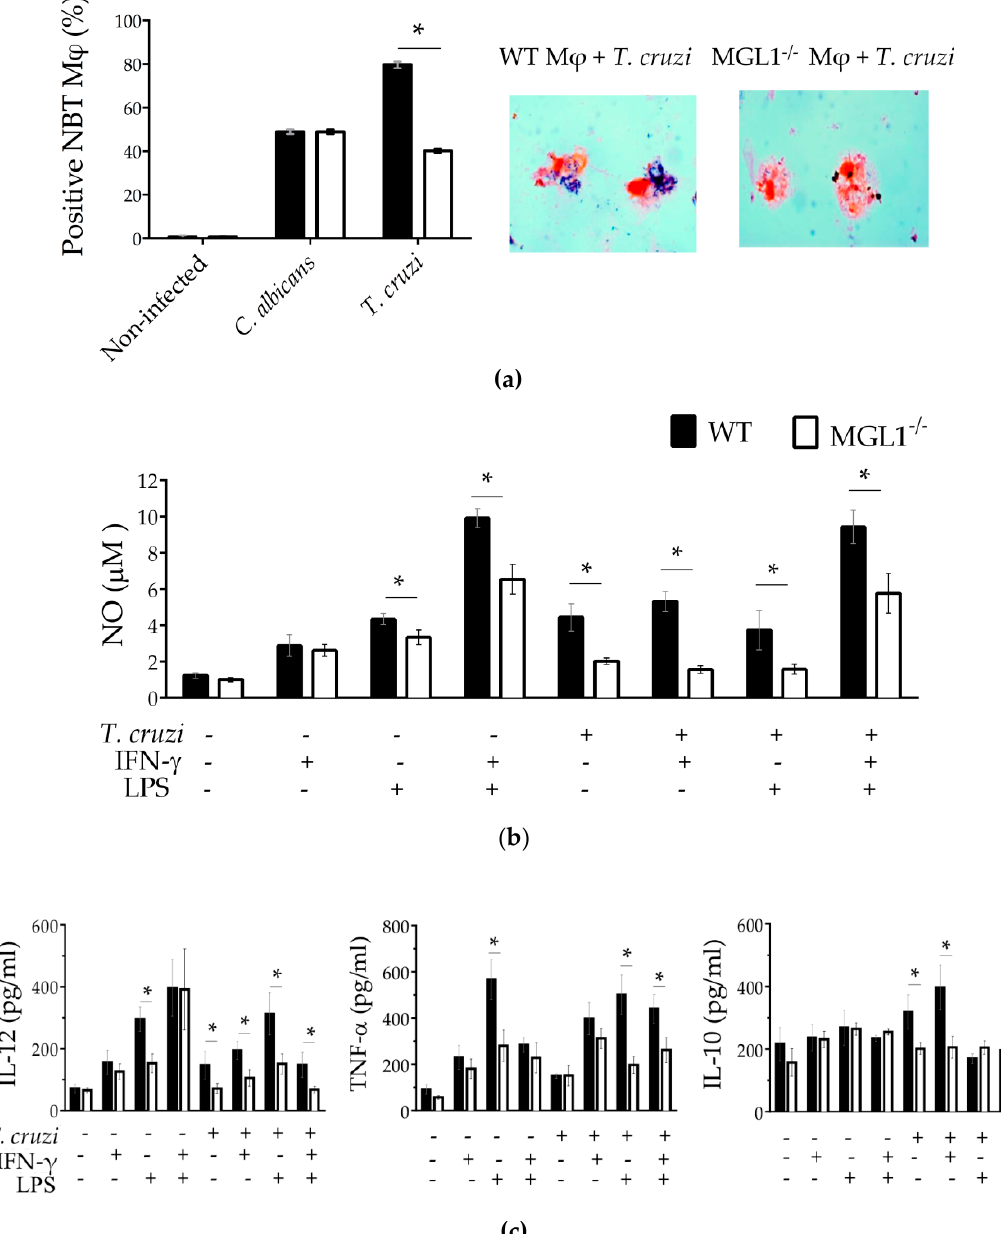
Figure 3. MGL1 − / − PE-M φ have a deficient ROS, as well as NO and proinflammatory cytokine production during T. cruzi infection. ( a ) WT and MGL1 − / − PE-M φ were infected for 2 h with culture-derived epimastigotes of T. cruzi or Candida albicans (as positive control), and ROS production was analyzed. ( b ) PE-M φ from MGL1 − / − and WT mice were not treated or treated for 24 h with IFN- γ , LPS or IFN- γ / LPS followed by infection with epimastigotes of T. cruzi at a 10:1 parasite / M φ ratio. Non-internalized parasites were removed at 2 h post-infection; supernatants were taken for NO and ( c ) cytokine IL-12, TNF- α and IL-10 quantification. The results are representative of three experiments; * p < 0.05.